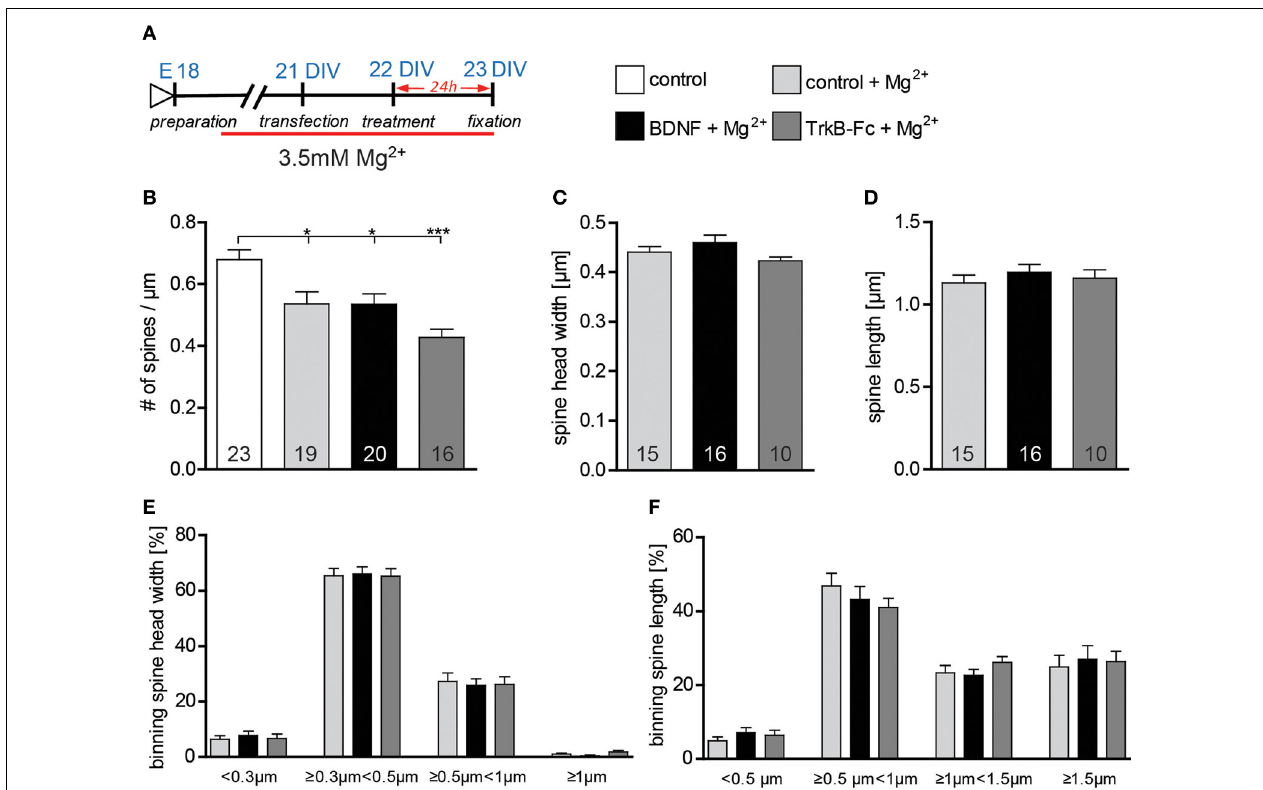
FIGURE 7 | (A) Experimental timeline. Primary neurons were cultivated for 2 weeks in high Mg 2 + medium and treated with BSA (control), BDNF or TrkB-Fc in high Mg 2 + . (B) Graphs comparing dendritic spine density between neurons cultivated in low or high Mg 2 + and treated with BSA (control), BDNF and TrkB receptor bodies (TrkB-Fc) in high Mg 2 + . (C) Histogram comparing the spine head width between primary hippocampal neurons cultivated and treated in high Mg 2 + with BSA (control), BDNF and TrkB receptor bodies (TrkB-Fc). (D) Histogram of the dendritic spine length between primary hippocampal neurons cultivated and treated in high Mg 2 + with BSA (control), BDNF and TrkB receptor bodies (TrkB-Fc). (E) Graph showing the binning of